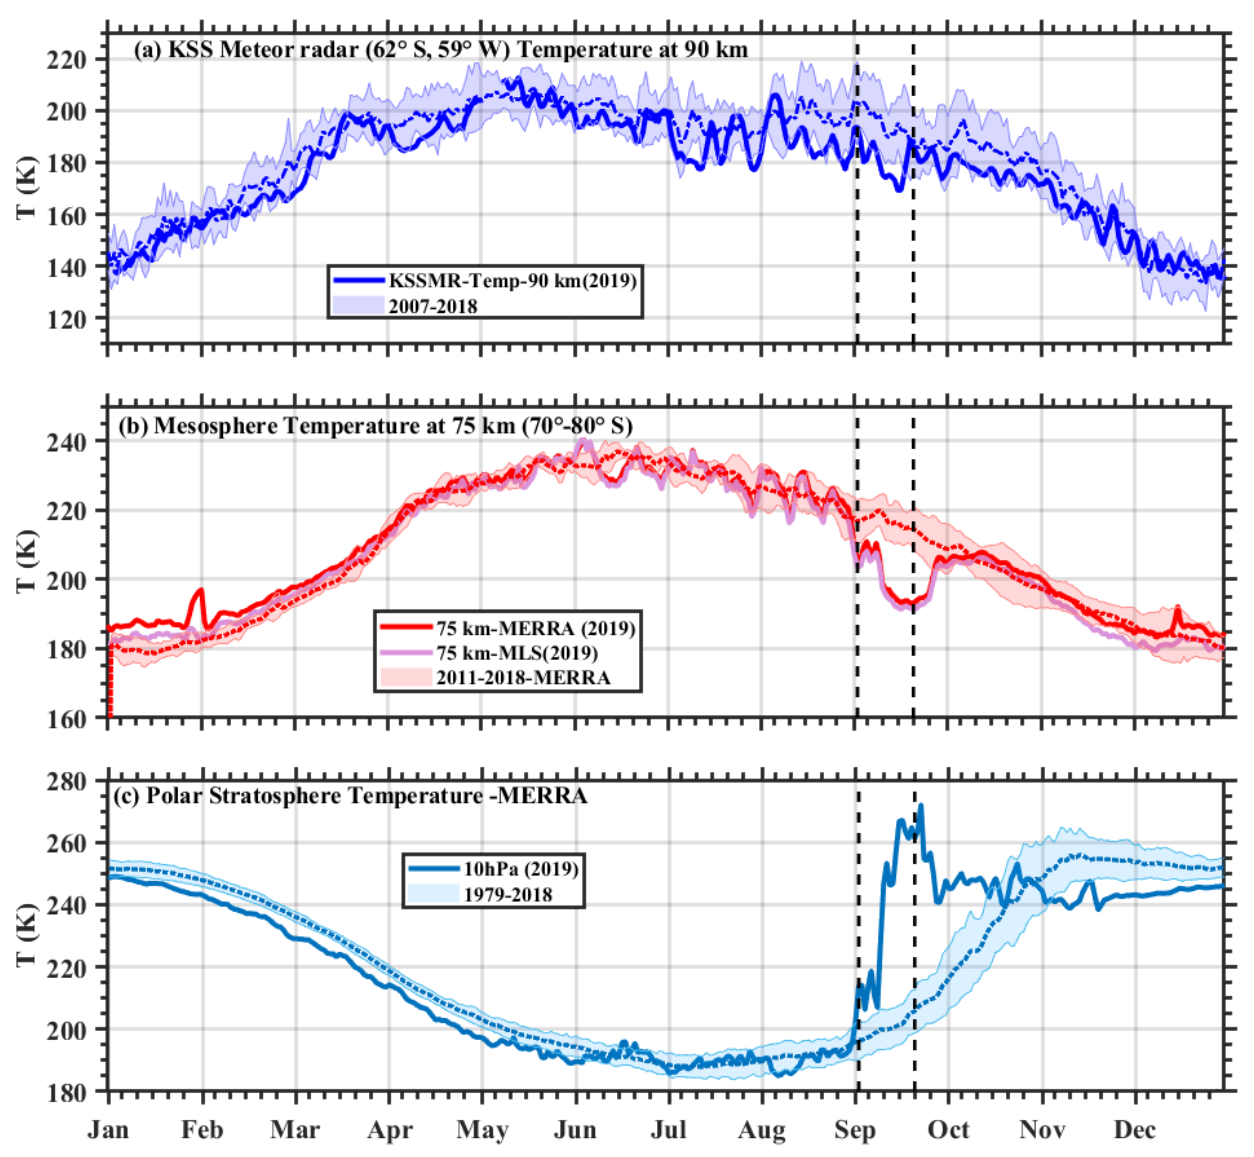
Figure 1. Daily mean variability of the ( a ) mesospheric temperatures at ~90 km obtained using KSS meteor radar (62° S, 59° W), and ( b ) at ~75 km using MLS and MERRA over 70°–80° S. ( c ) Polar stratospheric temperature at 10 hPa (~32 km) in the SH obtained from MERRA. In each panel, the temperature during 2019 is shown along with the climatological mean (dashed lines) and standard deviation (shaded areas). The vertical dashed lines indicate the onset and peak SSW days.